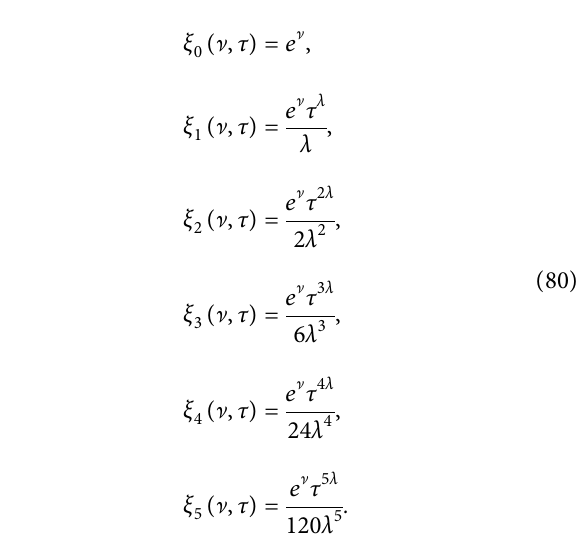
1 with ] 0 . 5. (cid:29) (cid:29)